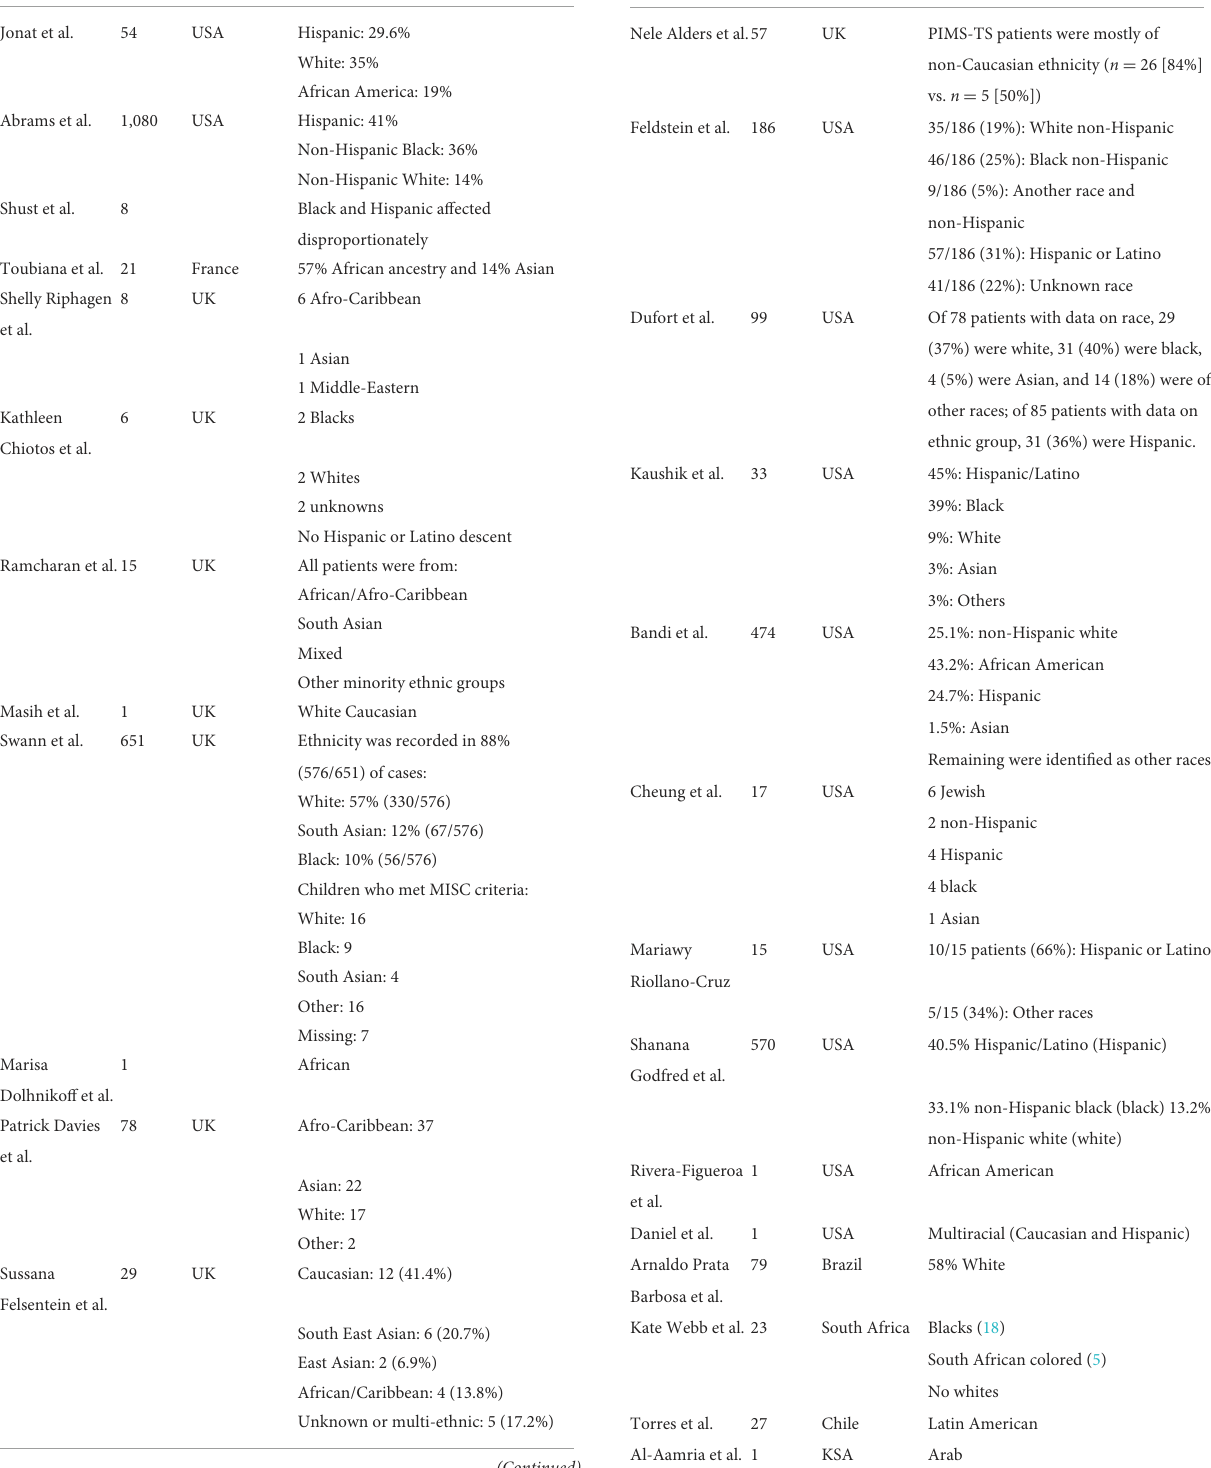
TABLE 2 MIS-C according to Race and Ethnicity in different